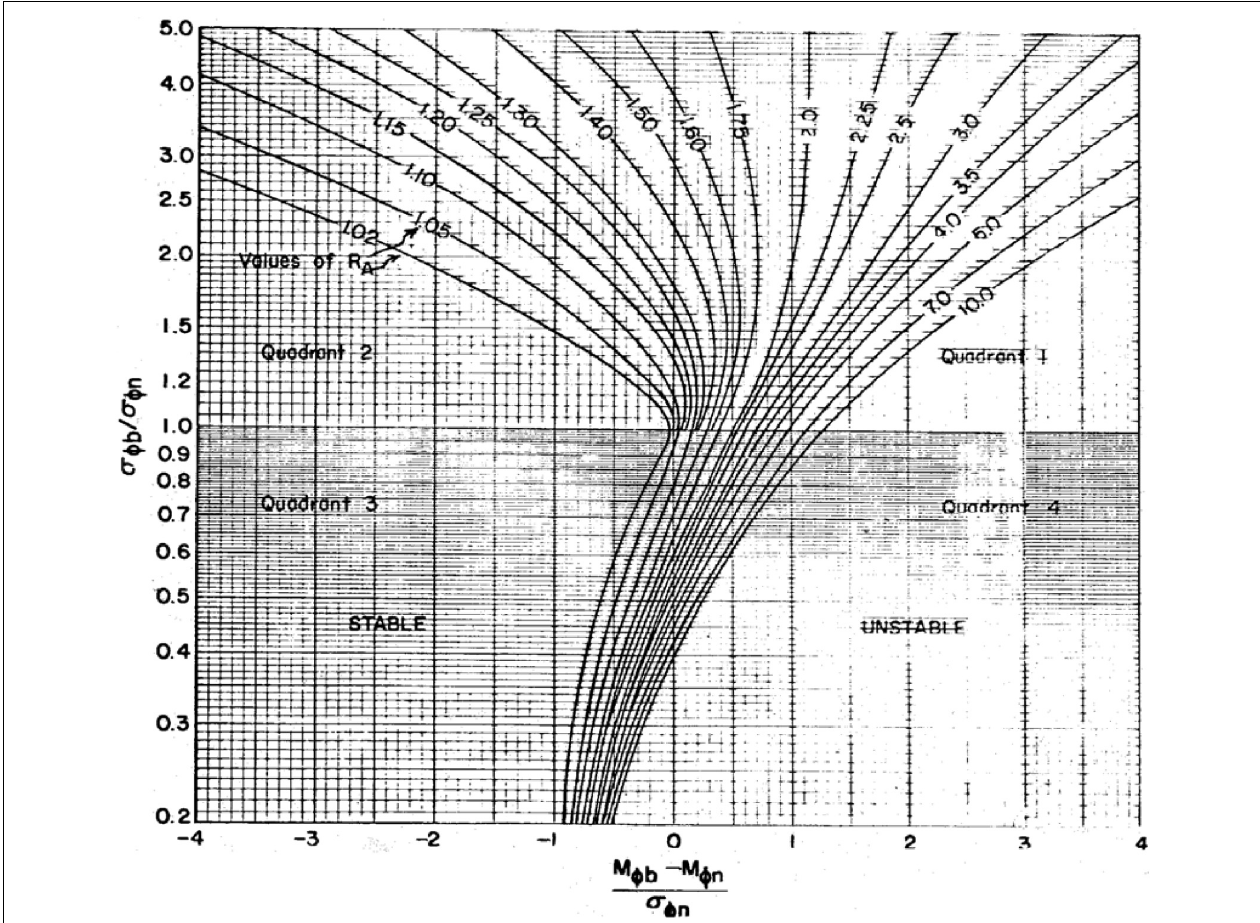
FIGURE 2 | James graph where R A can be found using Mean and Sorting parameters for the borrow (M ϕ b and σ ϕ b ) and the native sand (M ϕ n and σ ϕ n ) (U.S. Army Corps of Engineers, 1984).